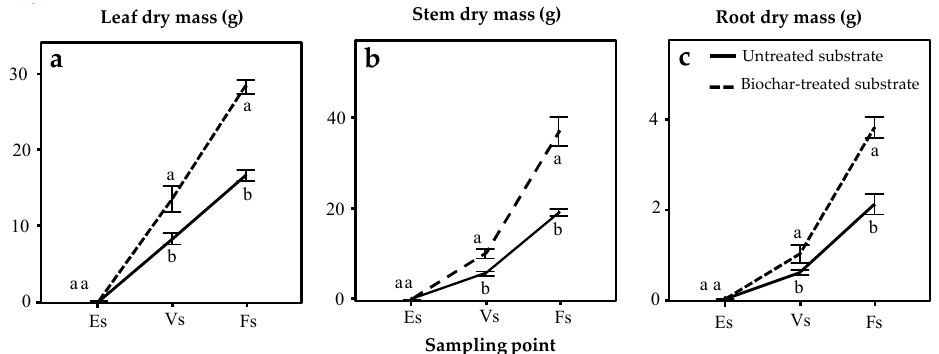
Figure 2. Leaf ( a ), stem ( b ), and root ( c ) dry mass measured at the early stage (Es, 36 days after plant germination), vegetative stage (Vs, 84 days after plant germination), and fruit stage (Fs, 140 days after plant germination) of Solanum lycopersicum var. cerasiforme plants grown on the two different substrates (solid line, plants in the untreated substrate; dashed line, plants in the biochar-treated substrate). Letters indicate statistically significant differences between the two treatments inside each sampling point ( p < 0.05) ( n = 10 ± SE).